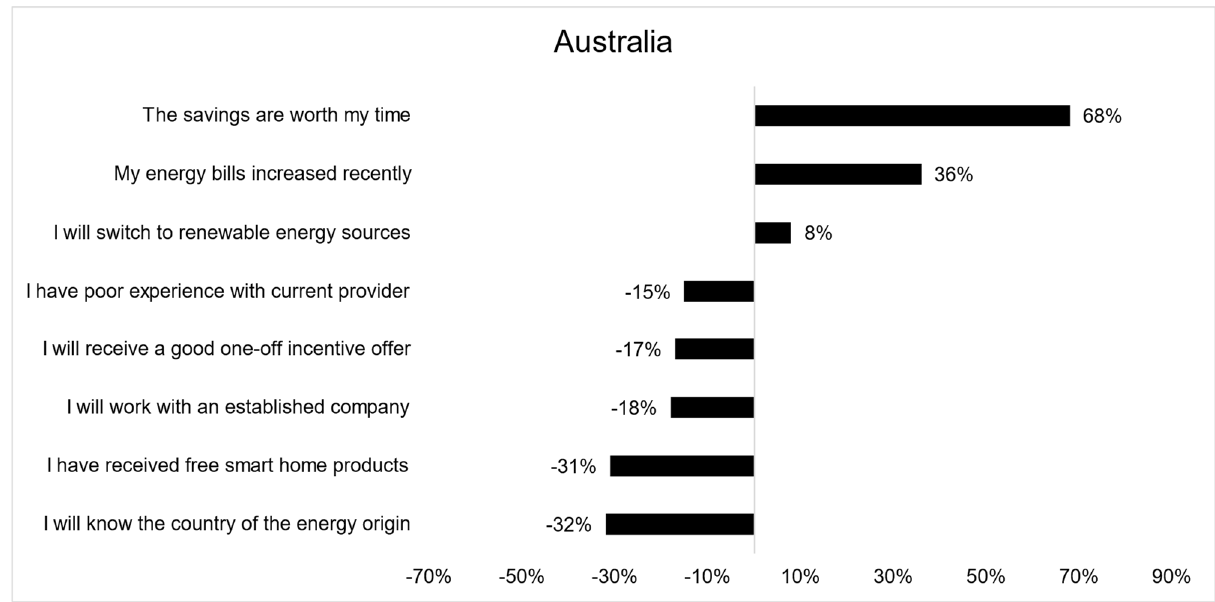
Figure 6. Utility attributes for various energy provider reasons in Australia. Source: own study.